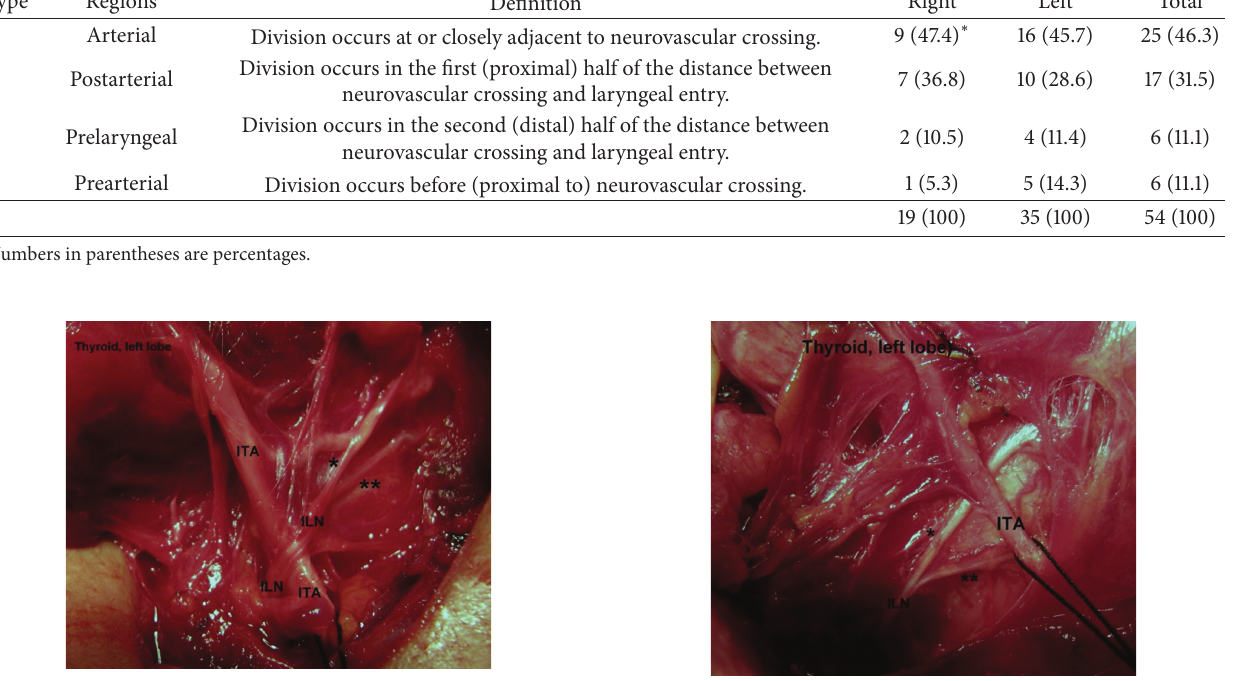
Figure 4: Terminal division of the left inferior laryngeal nerve (ILN) occurs at post-arterial segment (Type 2). ∗ Anterior branch. ∗∗ Posterior branch. ITA: inferior thyroid artery.